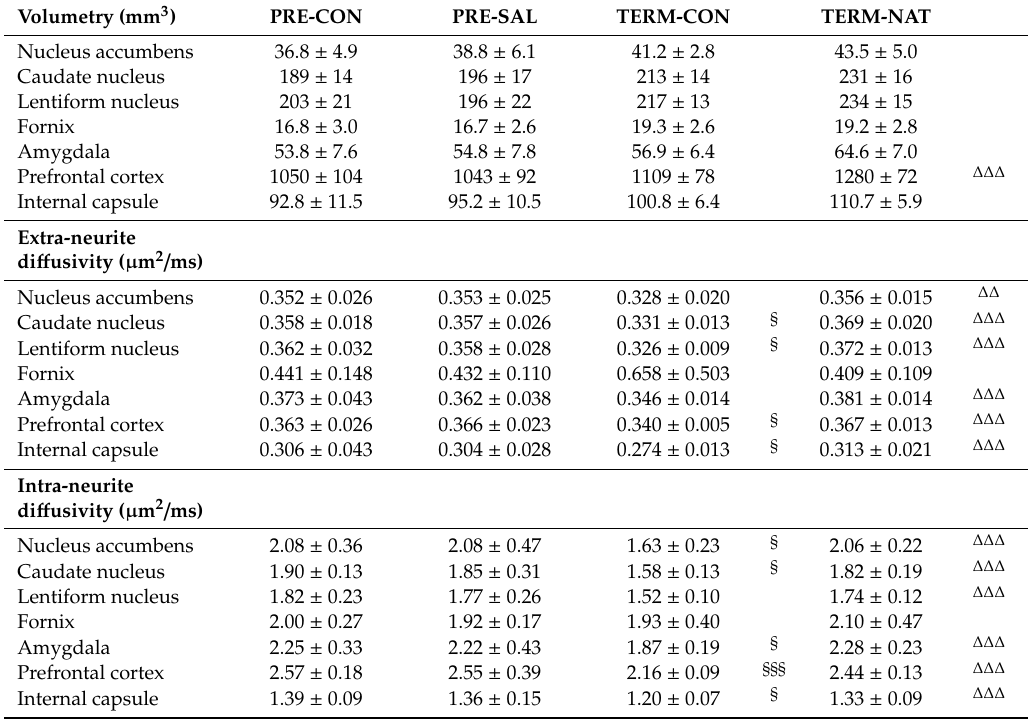
Table 1. Magnetic resonance imaging for the ROIs not shown in Figure